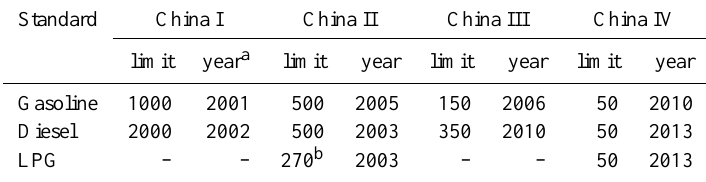
Table 3. Vehicle fuel standards and limits for sulfur content (mgkg − 1 ) implemented in Guangzhou after